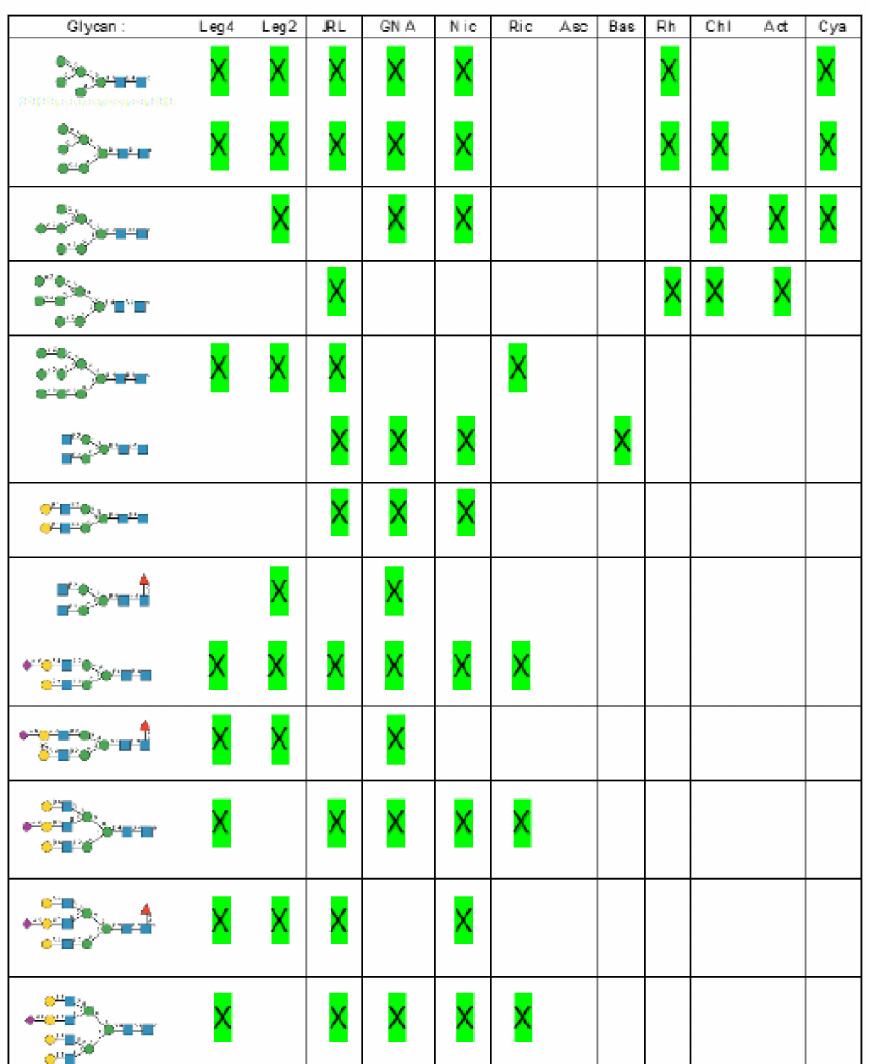
Figure 33. ARS-CoV-2 glycans that can be recognized (X) by Man-specific lectins from plants, mushrooms, algae, and cyanobacteria, as predicted from the results of glycan arrays performed with purified lectins: Leg4 (Con A): single-chain legume lectins; Leg2 (PsA, LcA): two-chain legume lectins; JRL (Morniga-M): jacalin-related lectins; GNA (GNA, ASA): GNA-like lectins; Nic: Nictaba from Nicotiana tabacum ; Ric: ricin-B from Ricinus communis ; Asc (NcCVN): lectins from Ascomycota; Bas (ABA): lectins from Basidiomycota; Rh (griffithsin, KAA-2): lectins from Rhodophyta; Chl (BCA): lectins from Chlorophyta; Act (actinohivin): lectins from actinomycetes; Cya (cyanovirin): lectins from